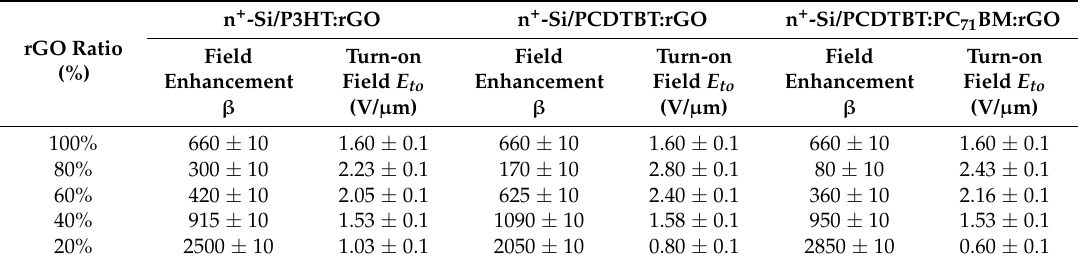
Figure 7. The evolution of the emission current density at a constant bias voltage of 1500 volts over a long period of continuous operation for the best rGO cathodes measured.